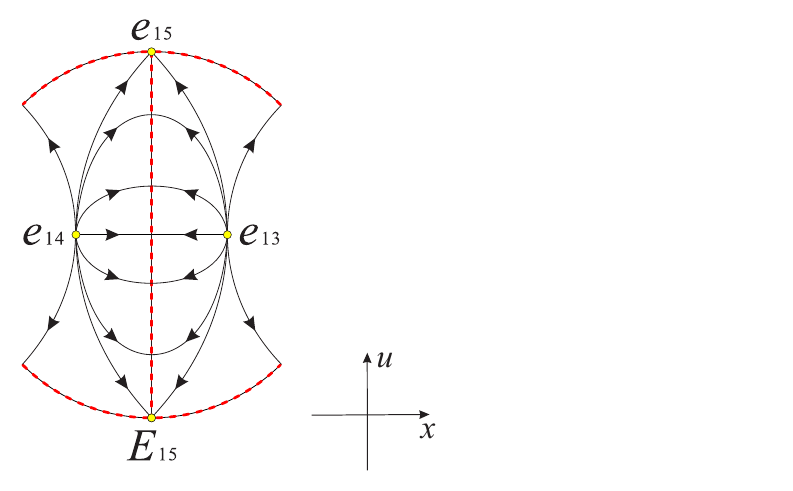
Figure 28. The global phase portrait of system (38) on the invariant plane z = 0 restricted to the region x 2 − u 2 ≤ 1. E 15 is the diametrically opposite point of e 15 on Poincaré disc.